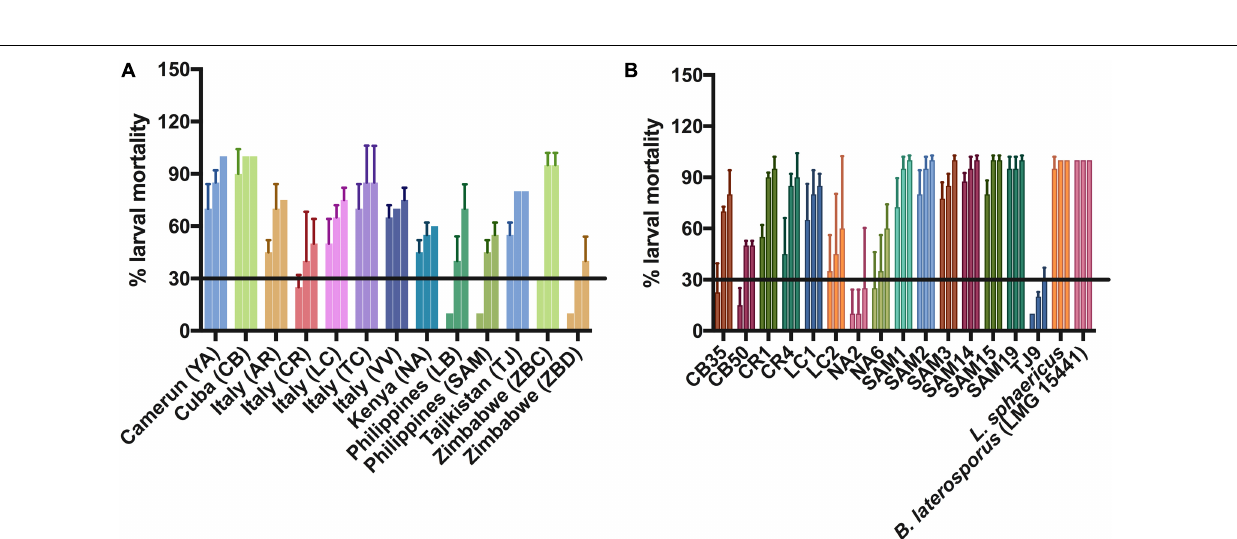
Frontiers in Microbiology |